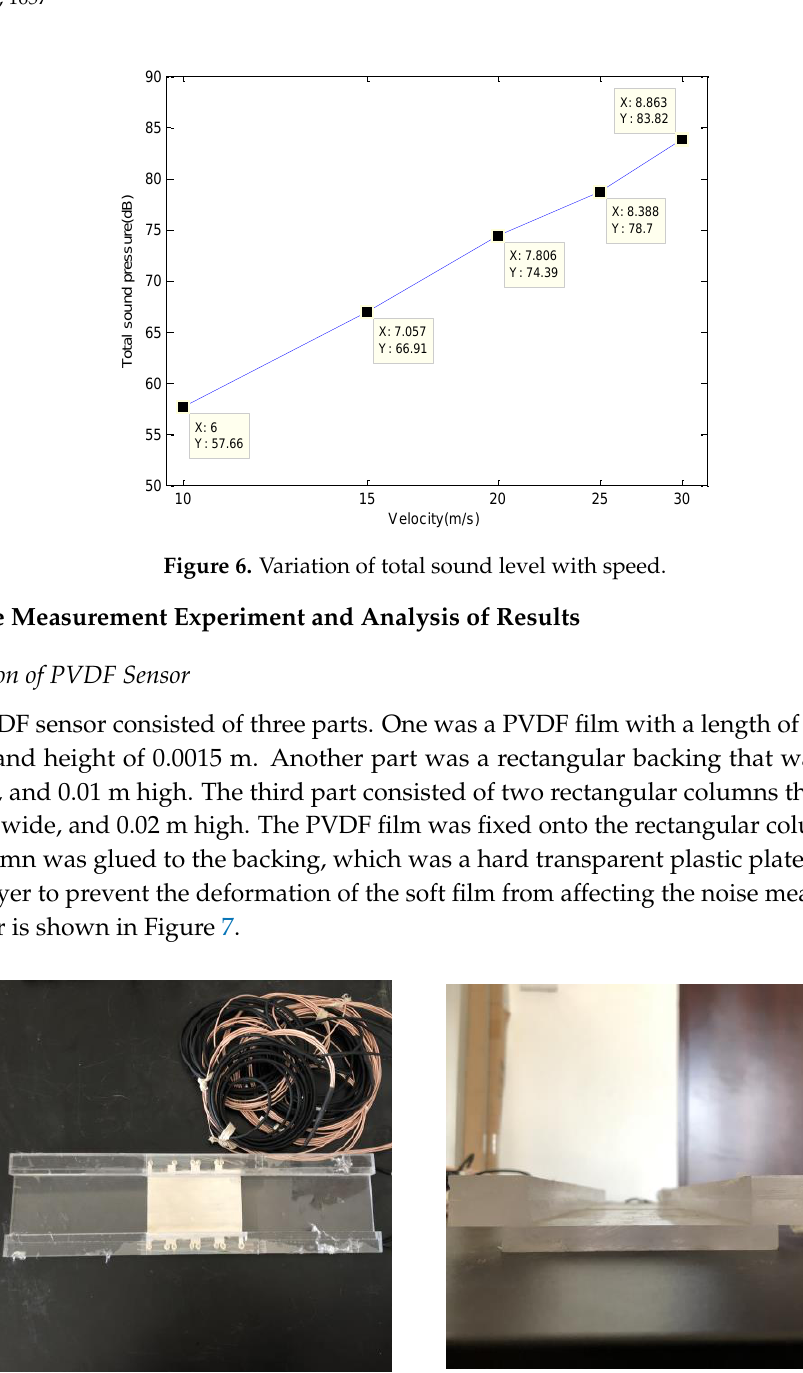
Sensors 2019 , 19 7 of 13 Figure 5. Frequency response curves for different wind speeds. Table 2. Total sound level for different wind speeds. Wind Speed (m/s)